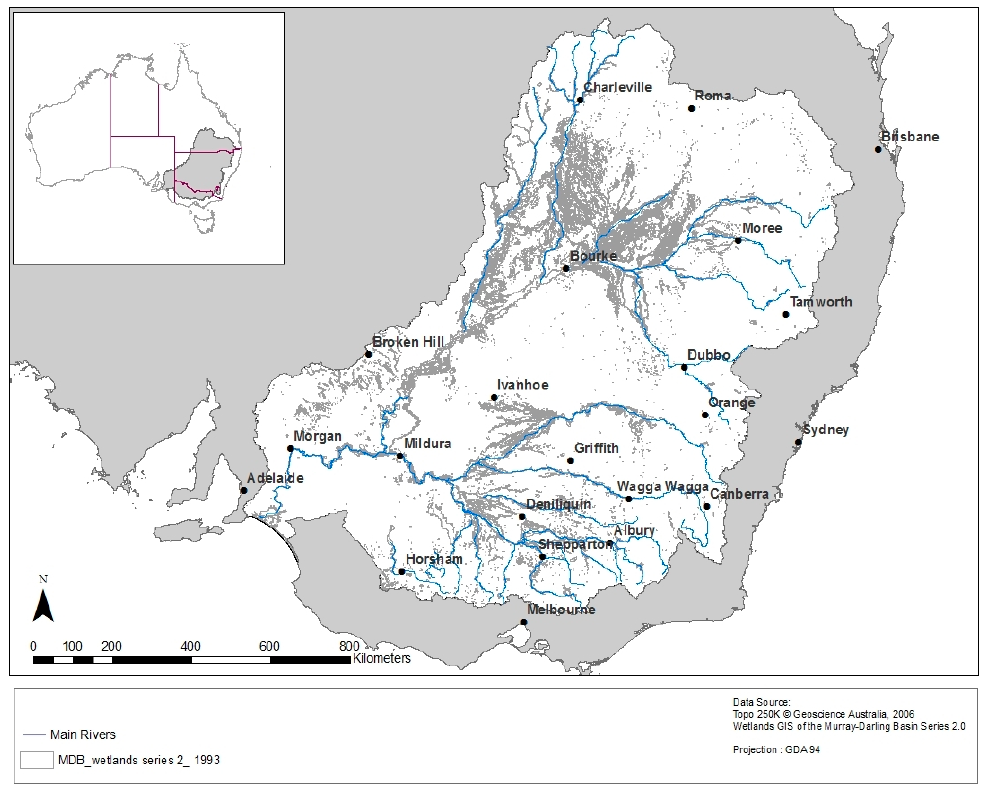
Figure 2. Major rivers and the extent of floodplain wetlands in the MDB [45].